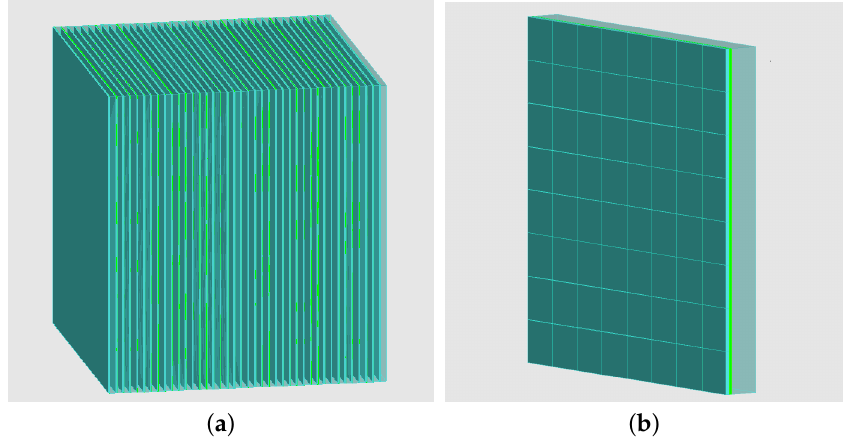
Figure 2. The HCAL structure visualization using Geant4: ( a ) an HCAL module with a transverse size of 108 × 108 mm 2 and 40 longitudinal layers; ( b ) a longitudinal layer including a steel plate, scintillator tiles, and 2 mm-thick readout PCB. The transverse size of the scintillator tiles is set to 3 × 3 mm 2 . The thickness of a steel plate and a layer of scintillator tiles can be tuned, but with a fixed value of 0.12 λ I to meet the requirement of the CEPC